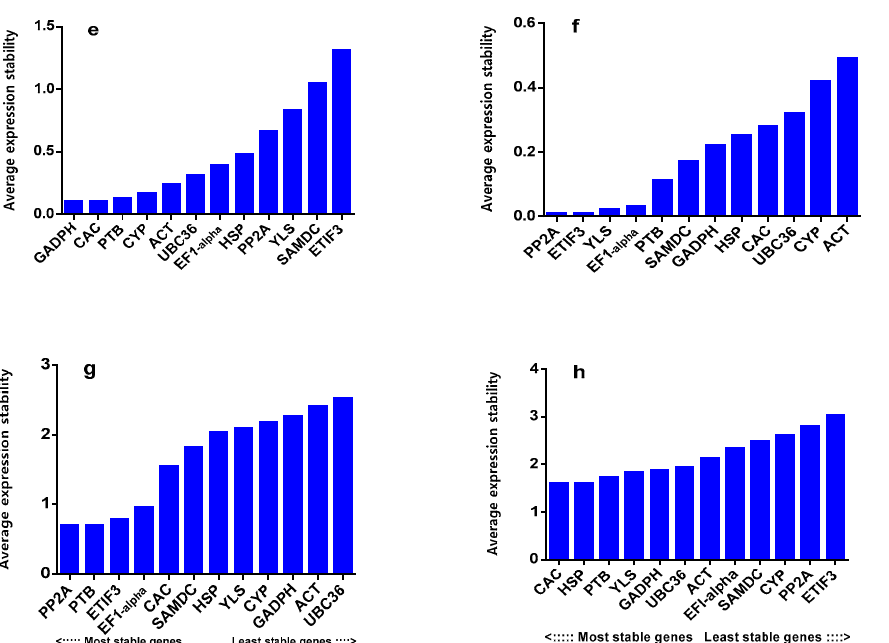
Figure 2. Average expression stability (M) calculated by geNorm under control, abiotic stress con- ditions, and different developmental stages in Ae. tauschii . ( a ) Control, ( b ) salinity, ( c ) drought, ( d ) heat, ( e ) cold, ( f ) seedling ( g ) development, and ( h ) total. ACT = actin, GAPDH = glyceraldehyde-3-phosphate dehydrogenase, EF1-alpha = elongation factor 1 alpha, SAMDC = S-adenosylmethionine decarboxylase proenzyme, UBC36 = ubiquitin-conjugating enzyme E2 36-like, CYP = peptidyl-prolyl cis-trans isomerase CYP19-4 -like, PTB = polypyrimidine tract-binding protein homolog 1-like, CAC = intracellular transport protein, PP2A = serine/threonine protein phosphatase 2A, ETIF3 = eukaryotic translation initiation factor3, HSP = protein microrchidia 2-like, YLS = thioredoxin-like protein.